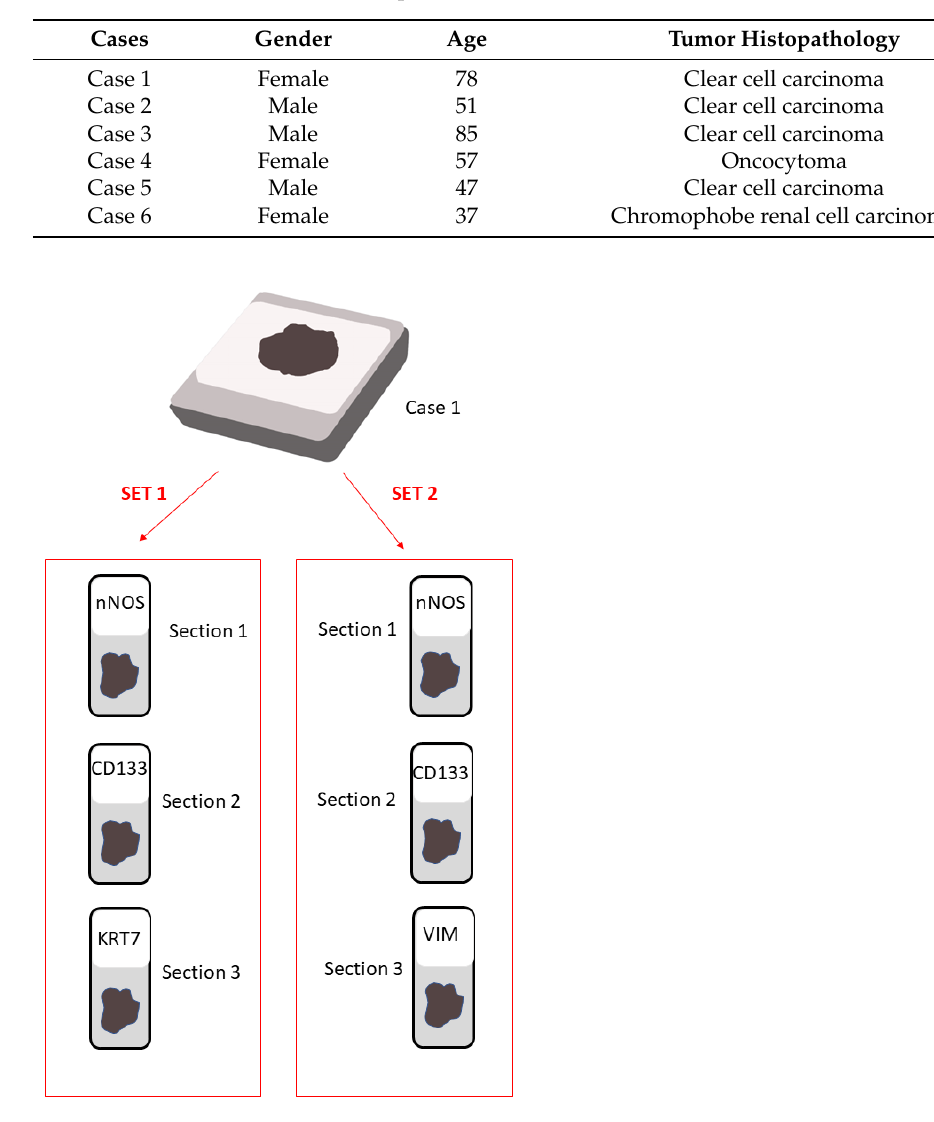
Table 1. Characteristics of tissue samples studied.